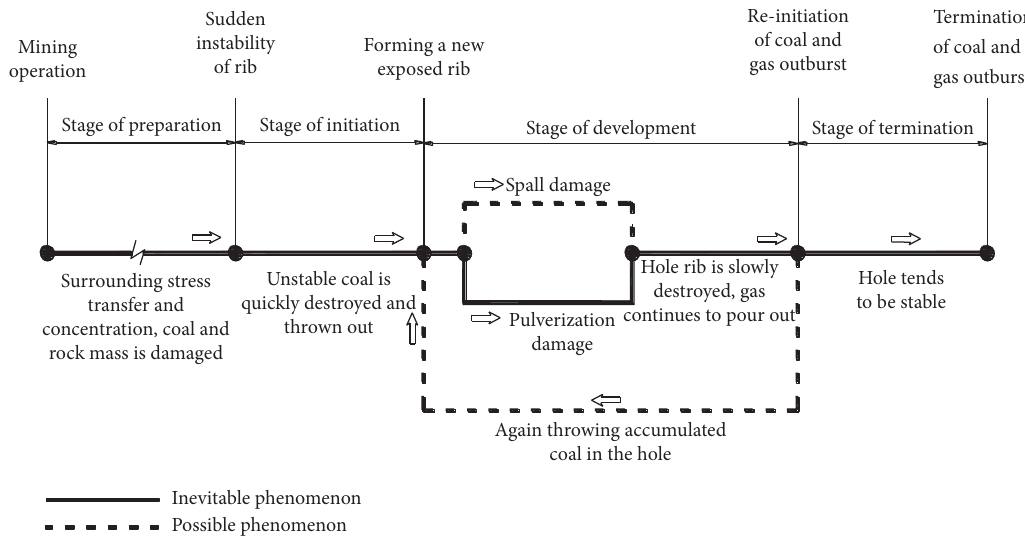
Figure 1: Phase division of coal and gas outburst